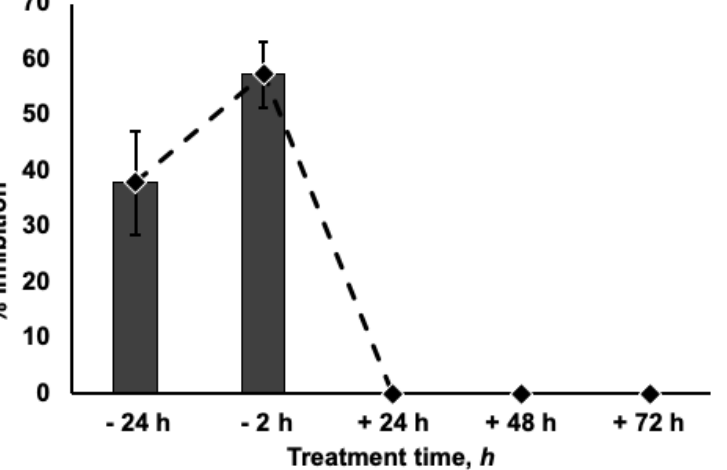
Figure 6. Effect of pre- and post-exposure treatment on antiviral activity of umifenovir. Umifenovir at dose 31.5 µ M was added to Vero CCL81 cells. After incubation for 24 and 2 h, the virus (SARS-CoV-2 Dubrovka strain 0.001 MOI) was added. For post-exposure treatment Vero CCL81 cells were infected with the same dose of virus. Umifenovir at a concentration of 31.5 µ M was then added 24, 48, or 96 h after infection.